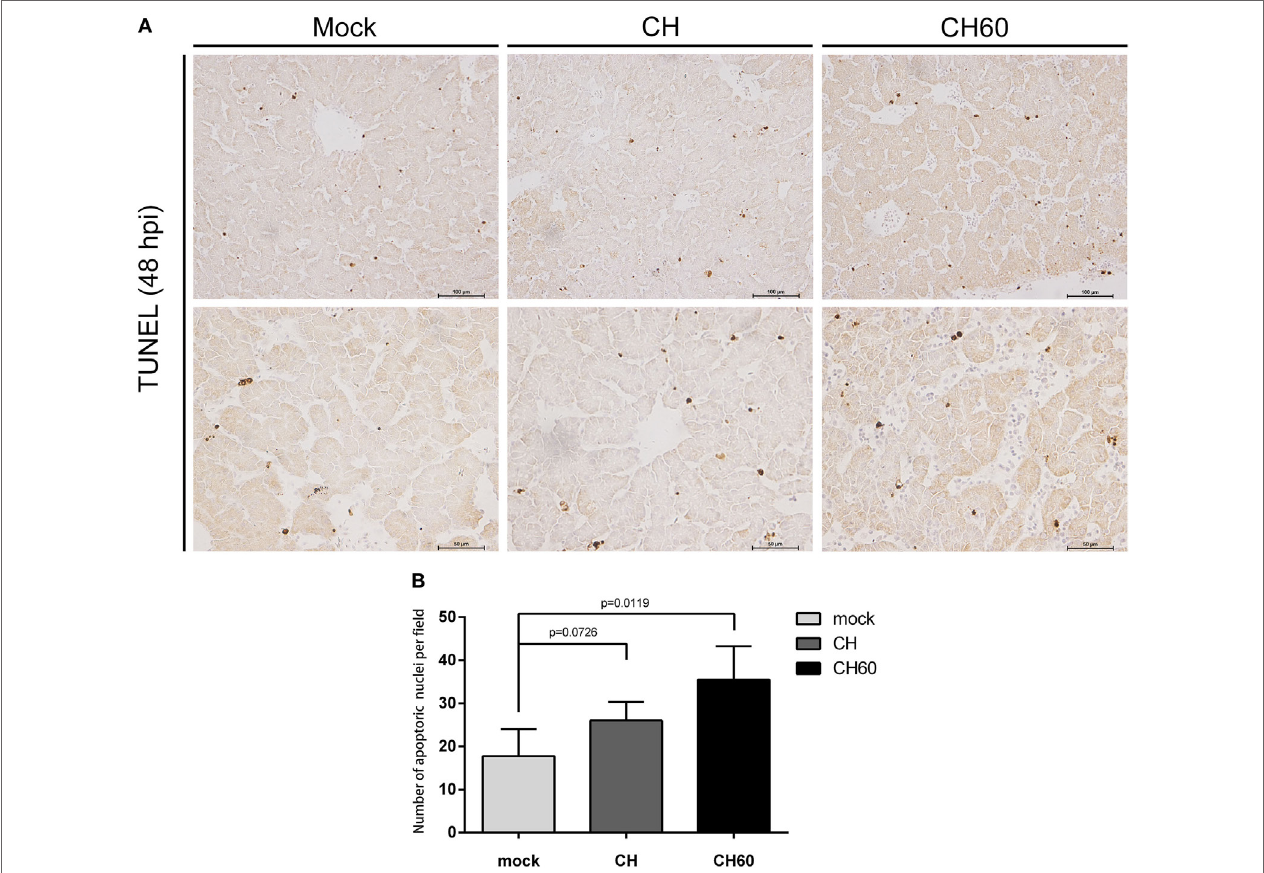
FigUre 3 | TUNEL assay of the livers of CH- or CH60-inoculated embryonated eggs at 48 hpi. (a) TUNEL staining of the livers of the mock, CH, and CH60 groups at 48 hpi. (B) Number of apoptotic nuclei identified by TUNEL staining. Student’s t- test was used for statistical analysis to compare the mock and treated groups.